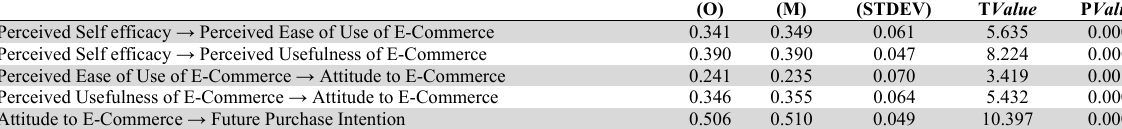
Direct, Indirect, and Total Effect Test